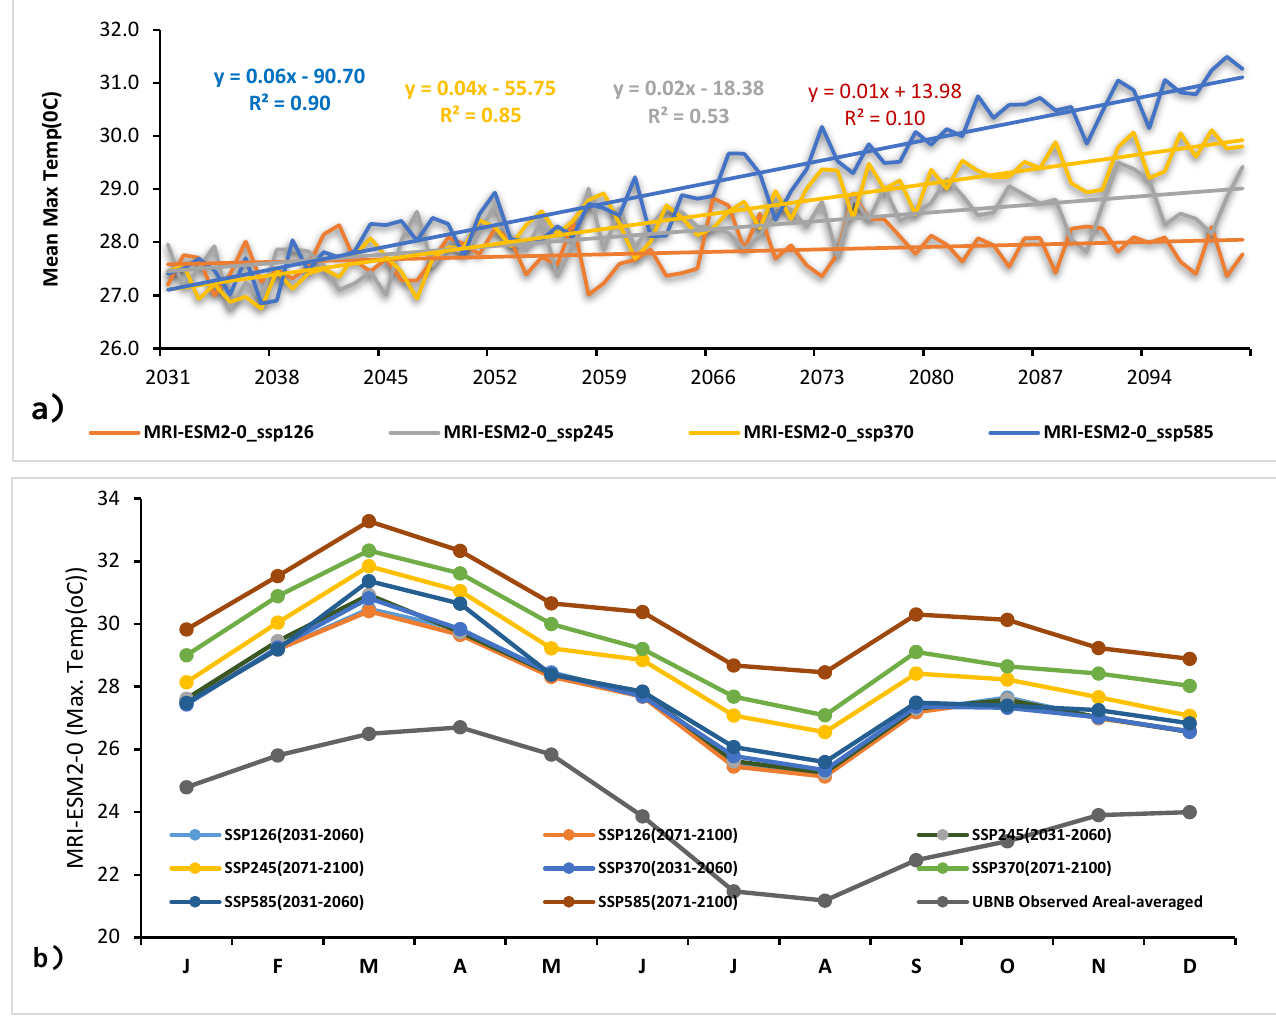
Figure 6. MRI-ESM2-0 model projections under SSP126, SSP245, SSP370, and SSP585 scenario for two future eras (2030s, 2070s). ( a ) Monthly mean max. temperature (°C) and ( b ) mean max. temperature (°C) mean annual cycle.